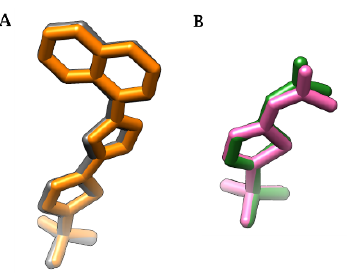
Figure 1. Superimposition of docked (orange and pink) and crystallographic (grey and green) poses of ( A ) 5-(1-(naphthalen-1-yl)-1H-1,2,3-triazol-4-yl)thiophene-2-sulfonamide bound to CA IX in pdb 5FL4, and B ) AAZ bound to CA XII in pdb 1JD0.